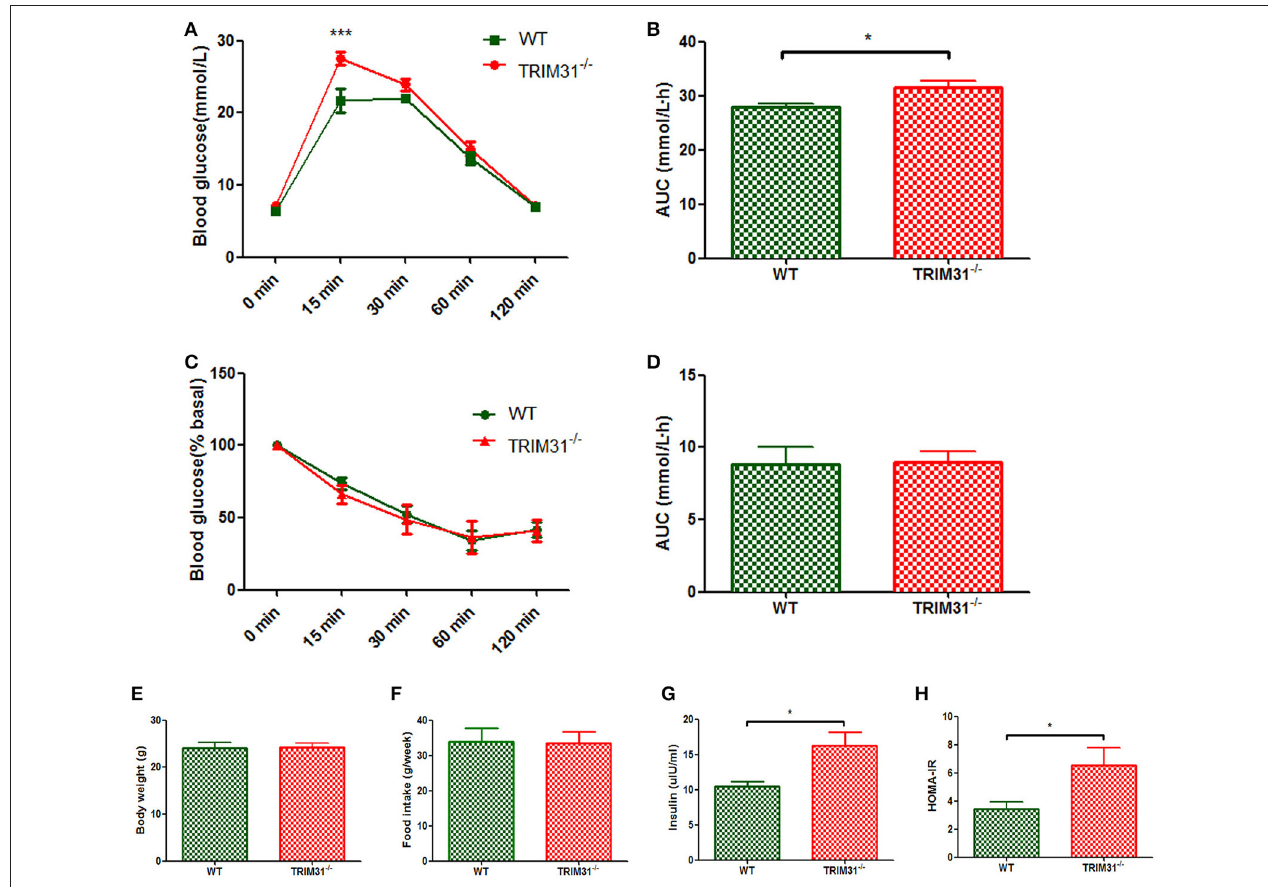
FIGURE 1 | Glucose metabolism of TRIM31 − / − and WT mice at age 16 weeks. (A) Glucose tolerance test, (B) AUC for glucose tolerance, (C) Insulin tolerance test, (D) AUC for insulin tolerance test, (E) Body weight at age 16 weeks, (F) Food intake, (G) Serum insulin level, (H) HOMA-IR level. n = 10, in each group. * P < 0.05 and *** P < 0.001 TRIM31 − / − vs. WT mice. AUC, area under the receiver operating characteristic curve; HOMA-IR, Homeostasis model assessment of insulin resistance; WT, wild-type; TRIM31, tripartite motif-containing protein